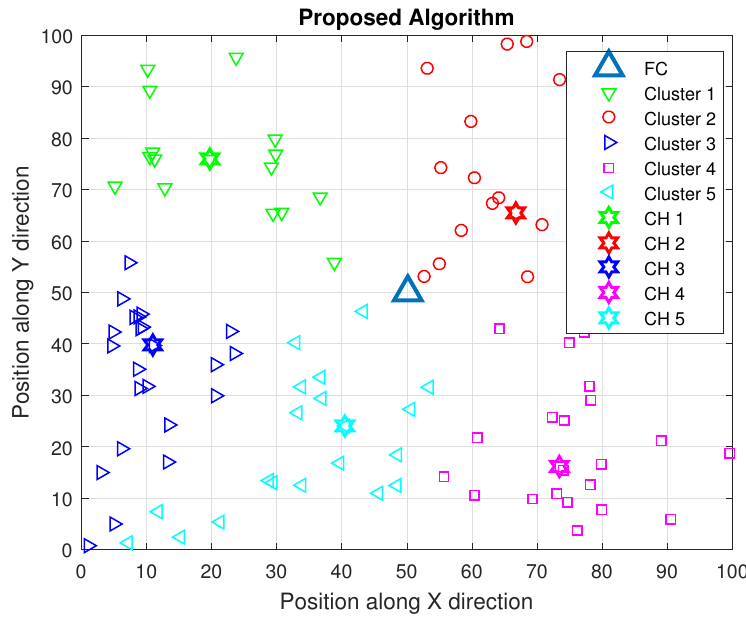
Figure 3. Proposed